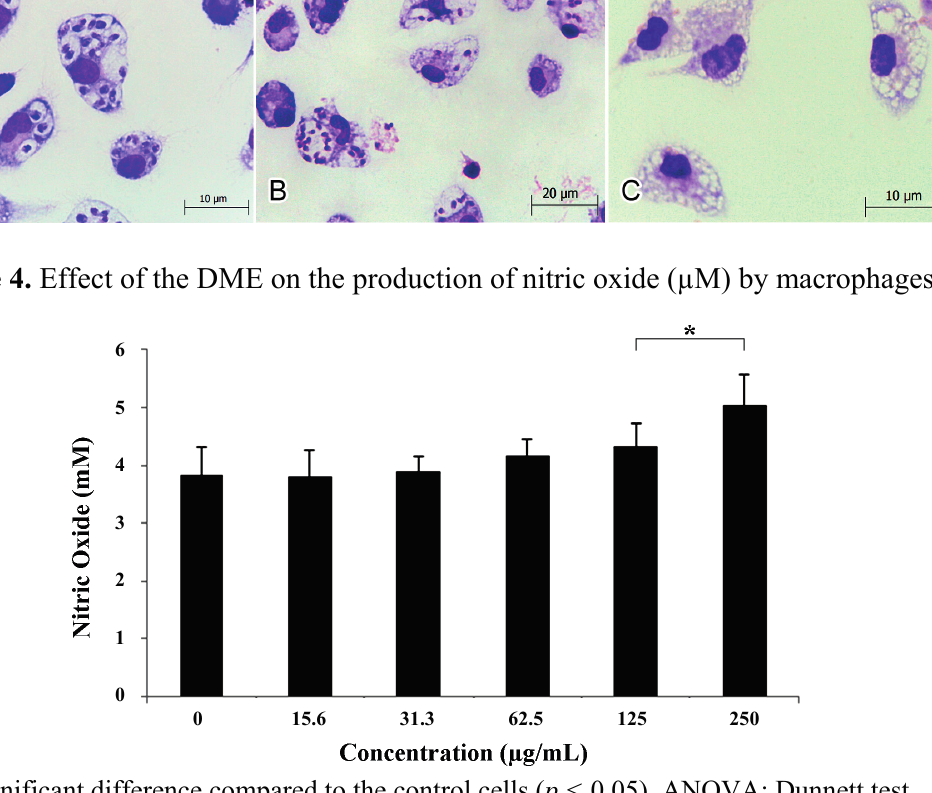
* Significant difference compared to the control cells ( p < 0.05), ANOVA; Dunnett